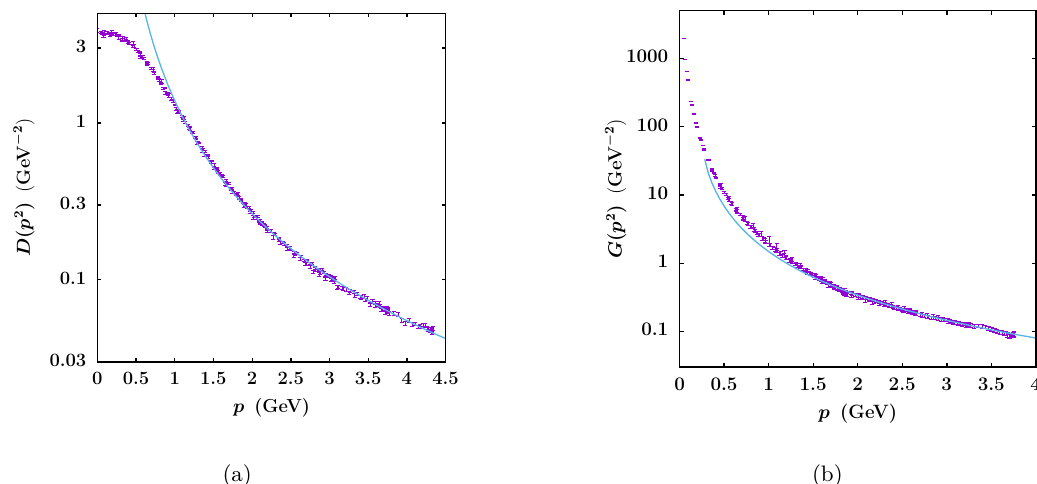
Figure 3 . Fit of the gluon (a) and ghost (b) propagators using perturbation-theory predictions [see eqs. (4.5) and (4.6)]. Note the logarithmic scale in the y axis. Also, recall that the variable p in the x axis corresponds to the square root of p 2 , defined in eq. (4.4) for the gluon propagator and in eq. (4.3) for the ghost